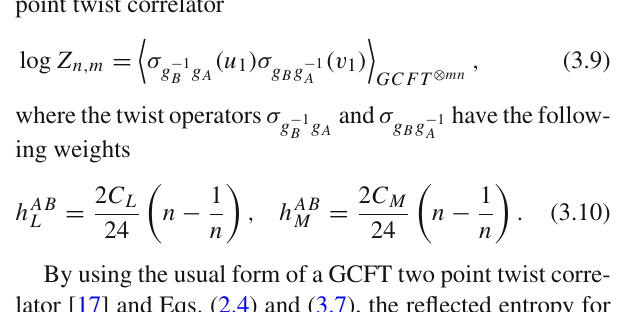
Fig. 2 Boosted intervals A and B in a GCFT 1 + 1 plane